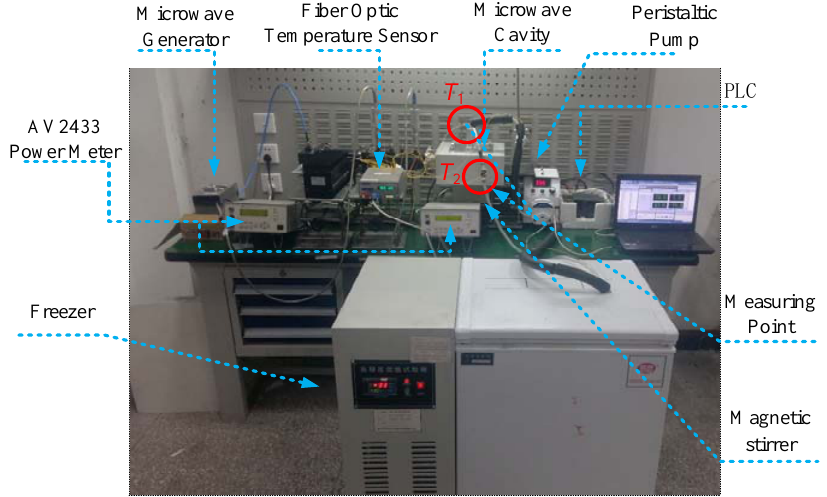
Figure 2. The photograph of the experimental system, T 1 is the temperature of liquid materials in reactor, T 2 is the temperature of coolant flowing out from the heat ‐ exchanger.